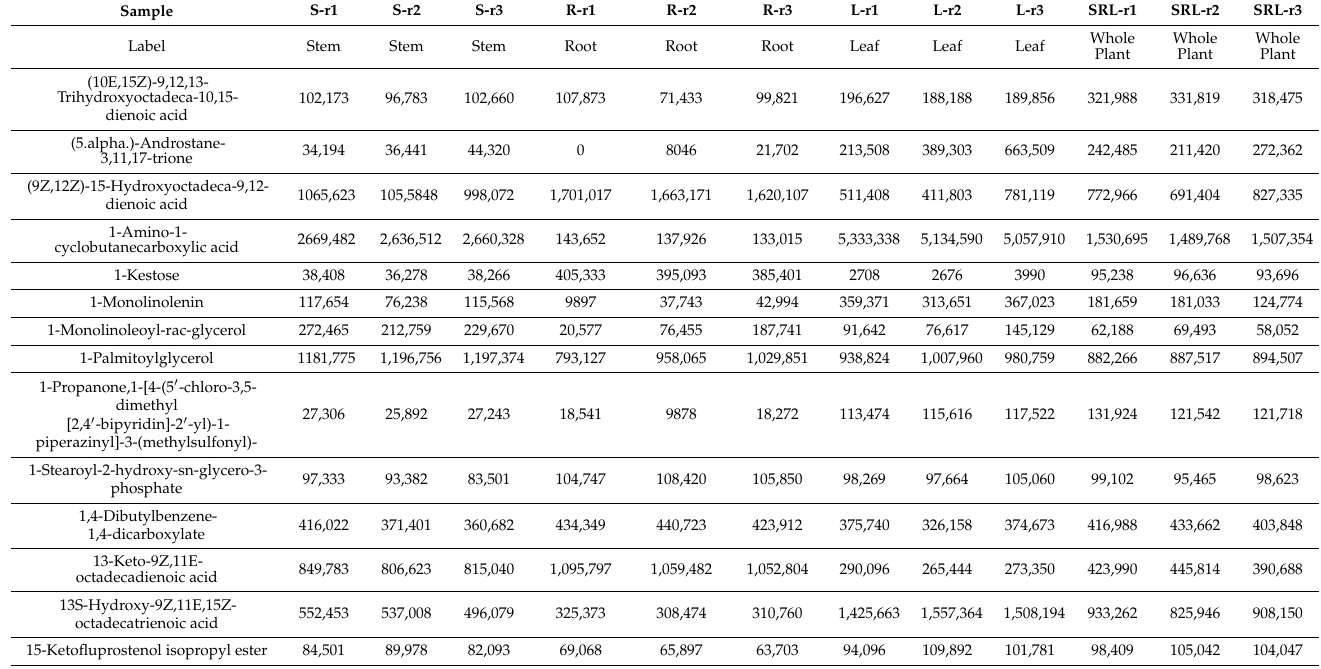
Table 1. B. pilosa metabolites identified by untargeted HPLC-MS